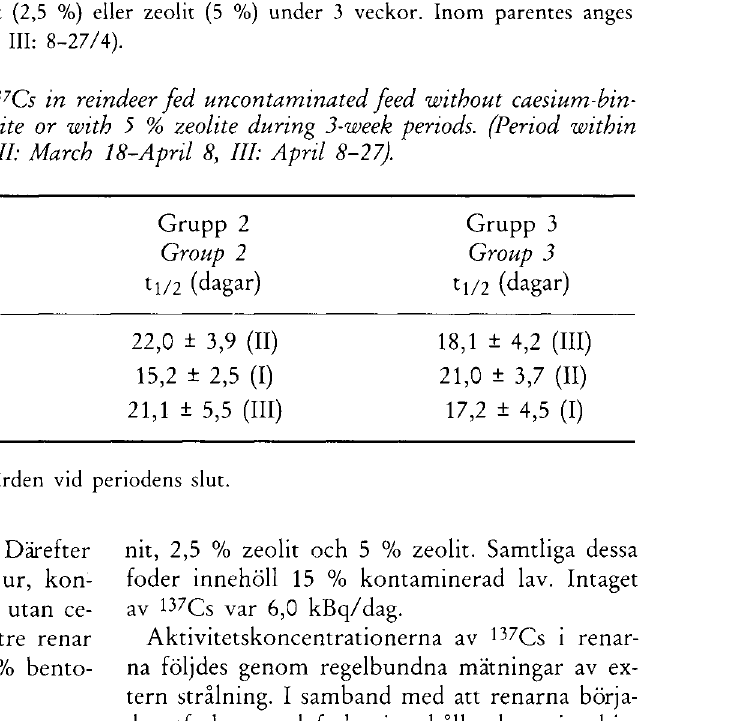
Tabell 1. Halveringstid (dagar, medelvarde ± S.D) for 137 Cs i renar utfodrade med foder utan cesiumbindare (kontroll) respektive med bentonit (2,5 %) eller zeolit (5 %) under 3 veckor. Inom parentes anges period (I: 26/2-18/3, II: 18/3-8/4, III: 8-27/4). Table 1. Half-time (days, mean ± S.D.) for 137 Cs in reindeer fed uncontaminated feed without caesium-bin der (controls), with 2.5 % bentonite or with 5 % zeolite during 3-week periods. (Period within parenthesis; I: Feb 26-March 18, IF March 18-April 8, III: April 8-27).